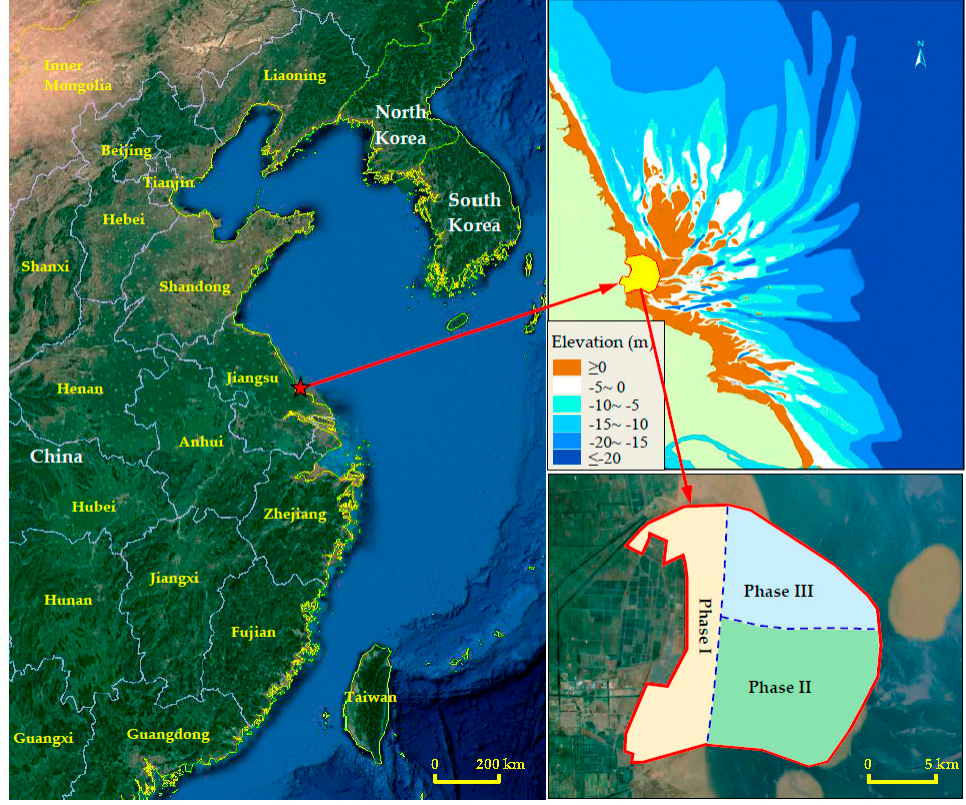
Figure 3. Geographical location of the Tiaozini Land Reclamation (32°42 ′ 28.61 ′′ E to 32°52 ′ 56.25 ′′ E and 120°53 ′ 35.10 ′′ N to 121°04 ′ 51.13 ′′ N).